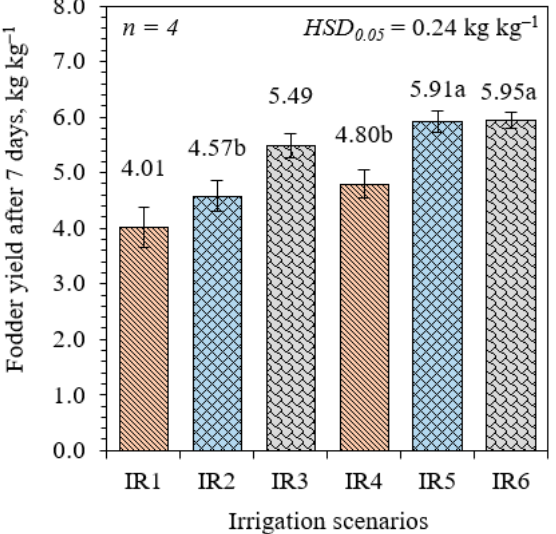
Figure 6. Wheat fodder yields after a 7-day growth cycle under different irrigation scenarios. Four repetitions n were performed in each scenario. Any two samples with a common letter are not significantly different ( p > 0.05), as assessed using honestly significant difference.